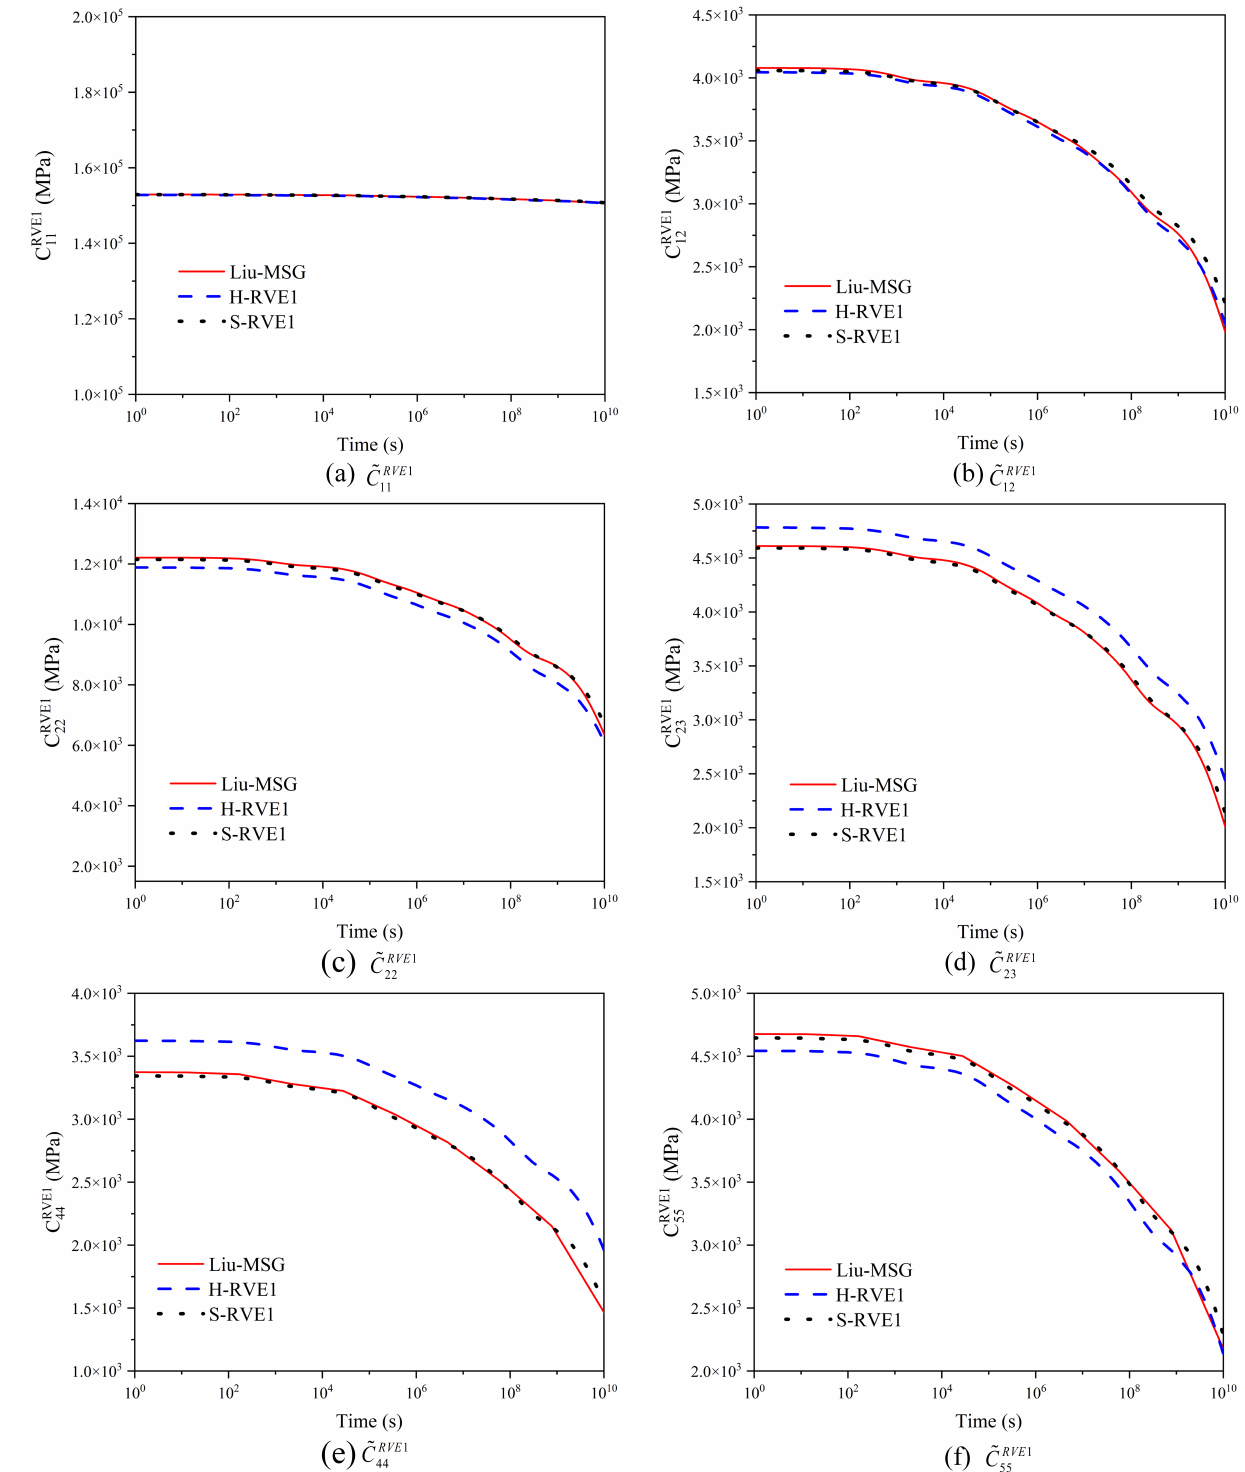
Figure 6.Figure 6. The effective relaxation stiffness of the yarn with no coating and twist